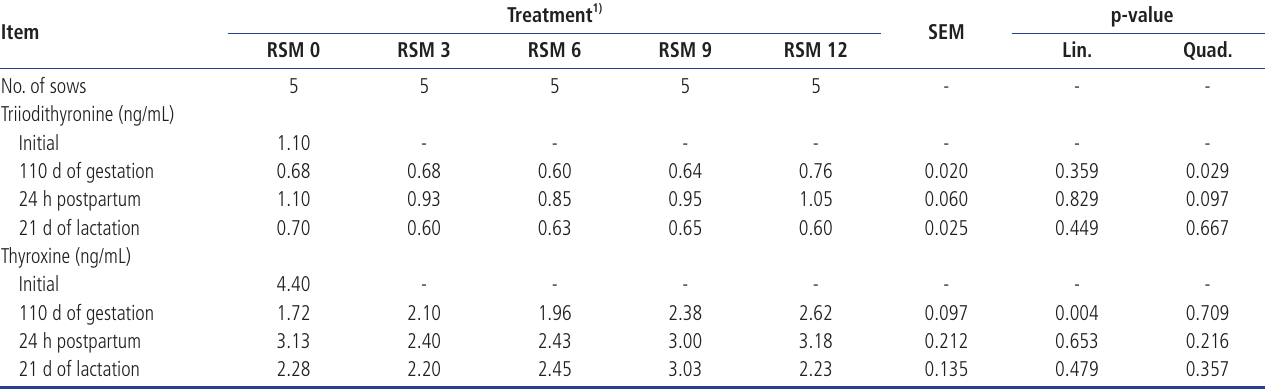
Table 6. Effect of rapeseed meal (RSM) supplementation levels in gestation diets on serum triiodithyronine (T3) and thyroxine (T4) concentrations in sows